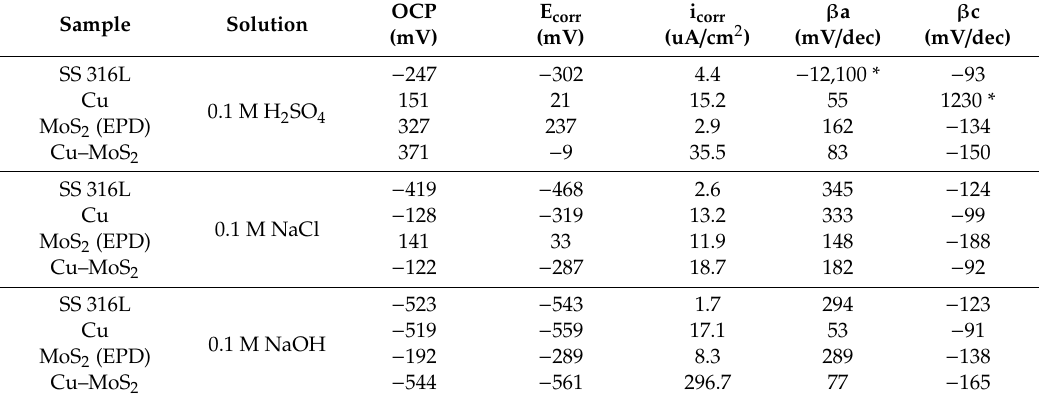
Table 5. Open circuit potential measurement (OCP) values after 1 h measurement and electrochemical kinetic parameters obtained from potentiodynamic polarizations presented in Figure 9, performed immediately after OCP measurements.